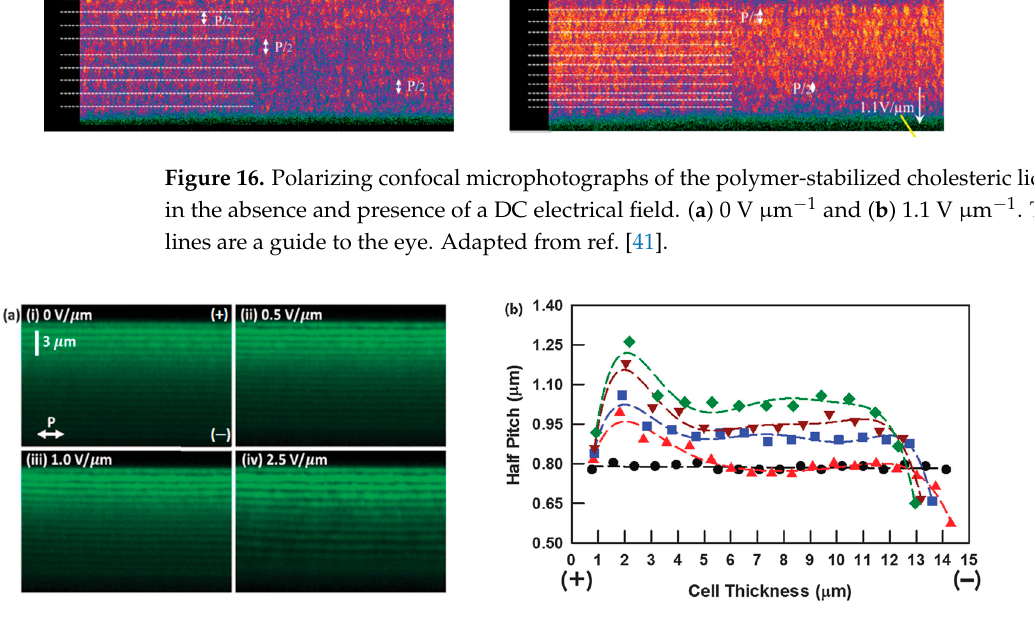
Figure 17. ( a ) Map of the fluorescence intensity by three-photon excitation along a 2D cross-section of a PSCLC without or with an applied DC field (reflection notch at 2.45 µm at zero field and ~15 µm cell thickness): (i) 0 V µm − 1 , (ii) 0.5 V µm − 1 , (iii) 1.0 V µm − 1 , and (iv) 2.5 V µm − 1 . The vertical direction is along the cell normal and the helical axis, the horizontal direction is parallel to the cell substrates. The white arrow labeled ‘‘P’’ in ( i ) is the polarization direction of the excitation light. The polarity of the DC voltage is indicated by the “(+)”and “( − )“ signs. ( b ) Magnitude of the half pitch through the cell thickness as obtained from the fluorescence images in ( a ) for the following values of the electric field: ( ● ) 0 V µm − 1 , ( ▲ ) 0.5 V µm − 1 , ( ■ ) 1.0 V µm − 1 , ( ▼ ) 2.0 V µm − 1 , and ( ) 2.5 V µ m − 1 . Composition of the CLC mixture: 0.2 wt.% I-369, 4 wt.% SL04151, 2 wt.% RM23, 2 wt.% CB15, and 91.8 wt.% MLC 2079. The PSCLC was formed by curing the mixture with exposure to 365 nm UV light at 100 mW cm − 2 for 5 min. Adapted from ref.